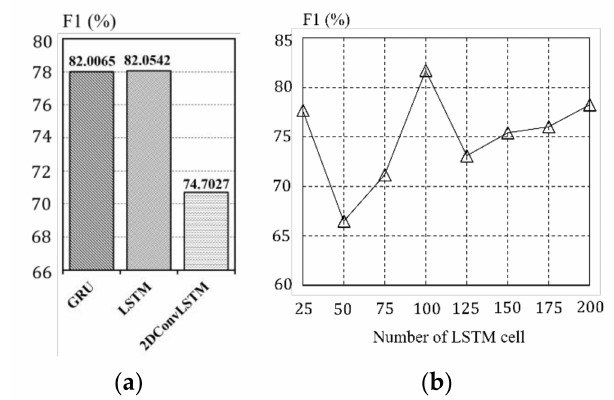
Figure 8. Experiment results with various hyperparameter setting: ( a ) VN algorithms; ( b ) number of LSTM cell.